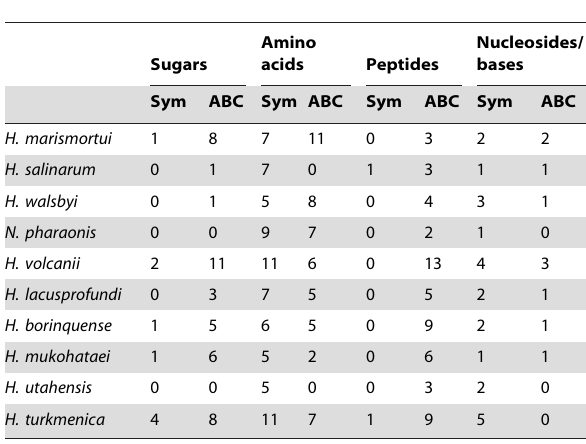
Table 2. Nutrient transport in